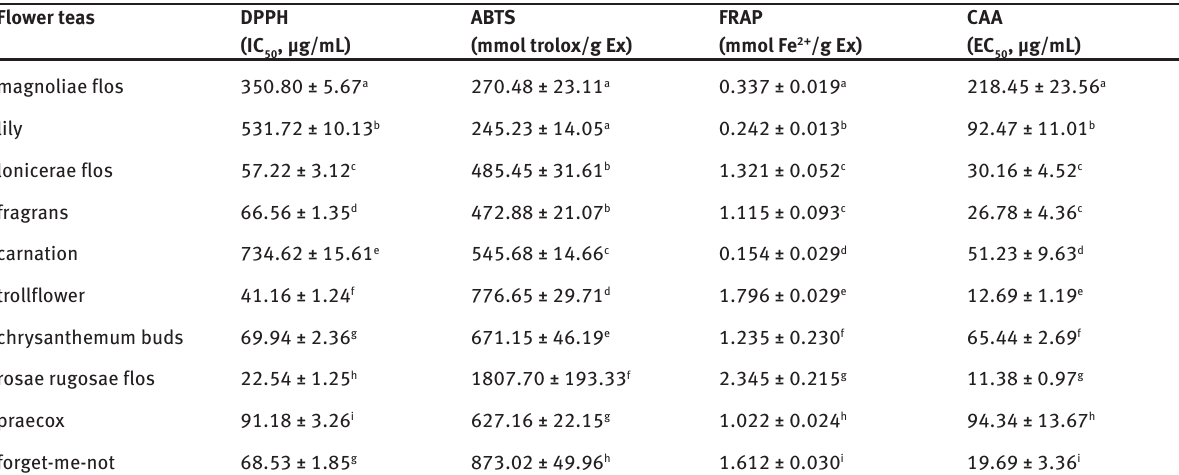
Table 2: The antioxidant activities of ten flower teas. Flower teas